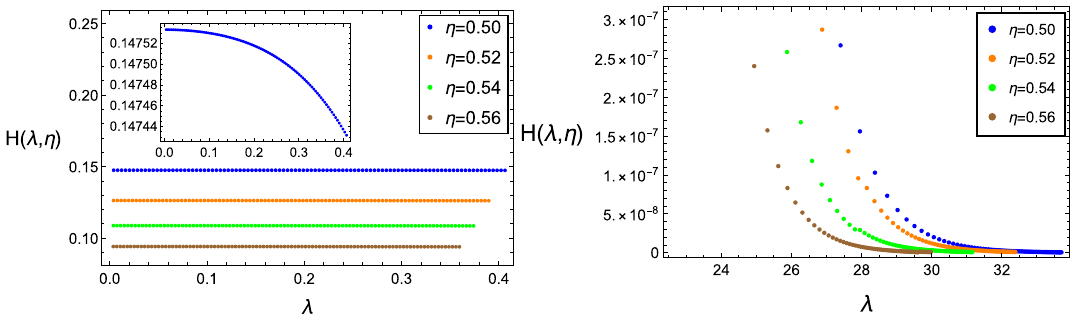
the parameters, α = 0 . 1, q = 1, k = 0 . 1, and (cid:9) AdS = 0 . 1, for the convenience of numerical calculations and